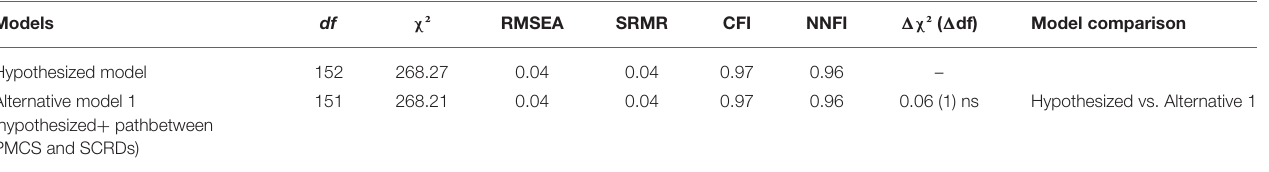
TABLE 3 | Fit indices for structural equation modeling (SEM).